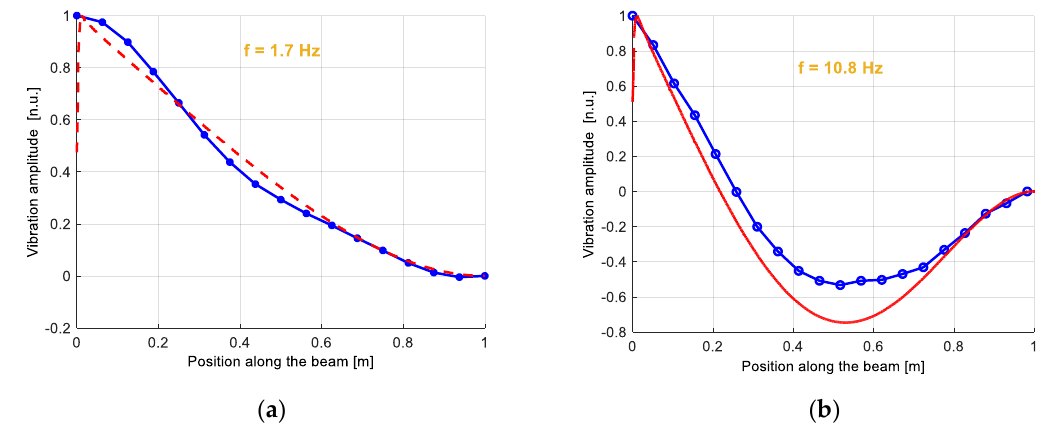
Figure 7. Dynamic strain amplitude related to the ( a ) first and ( b ) second mode of the cantilever beam. Mode frequencies are 1.7 Hz are 10.8 Hz, respectively. The blue lines represent the mode shapes measured using the SA-BOTDA method, while the red lines represent the FEM result [52].